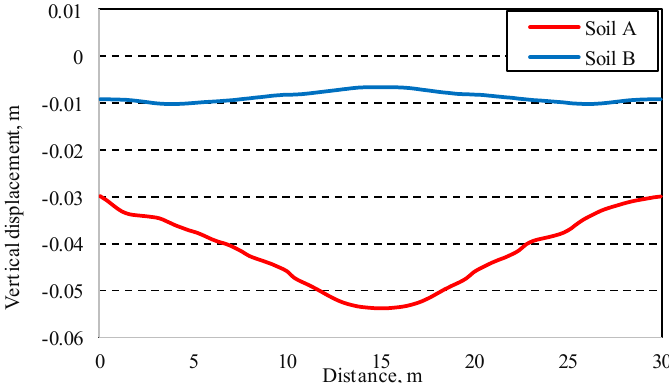
Figure 14: Maximum displacement along path (2) for soil (A) and